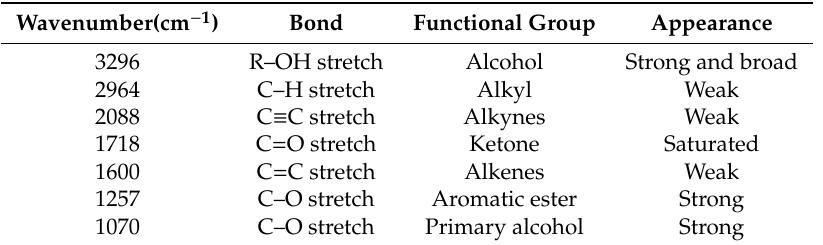
Table 4. Peaks properties of WW rosin.